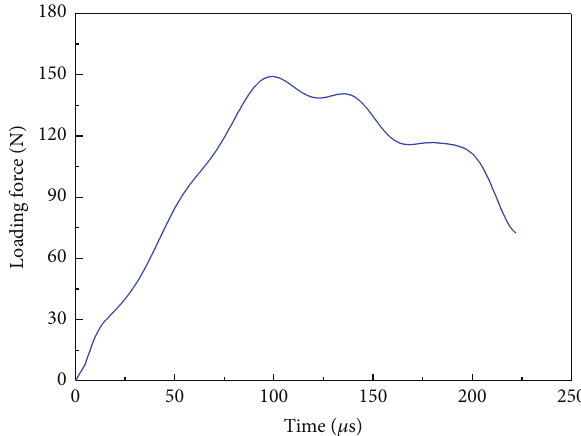
crack getting deflected along the interface rather than cutting the coarser particles.